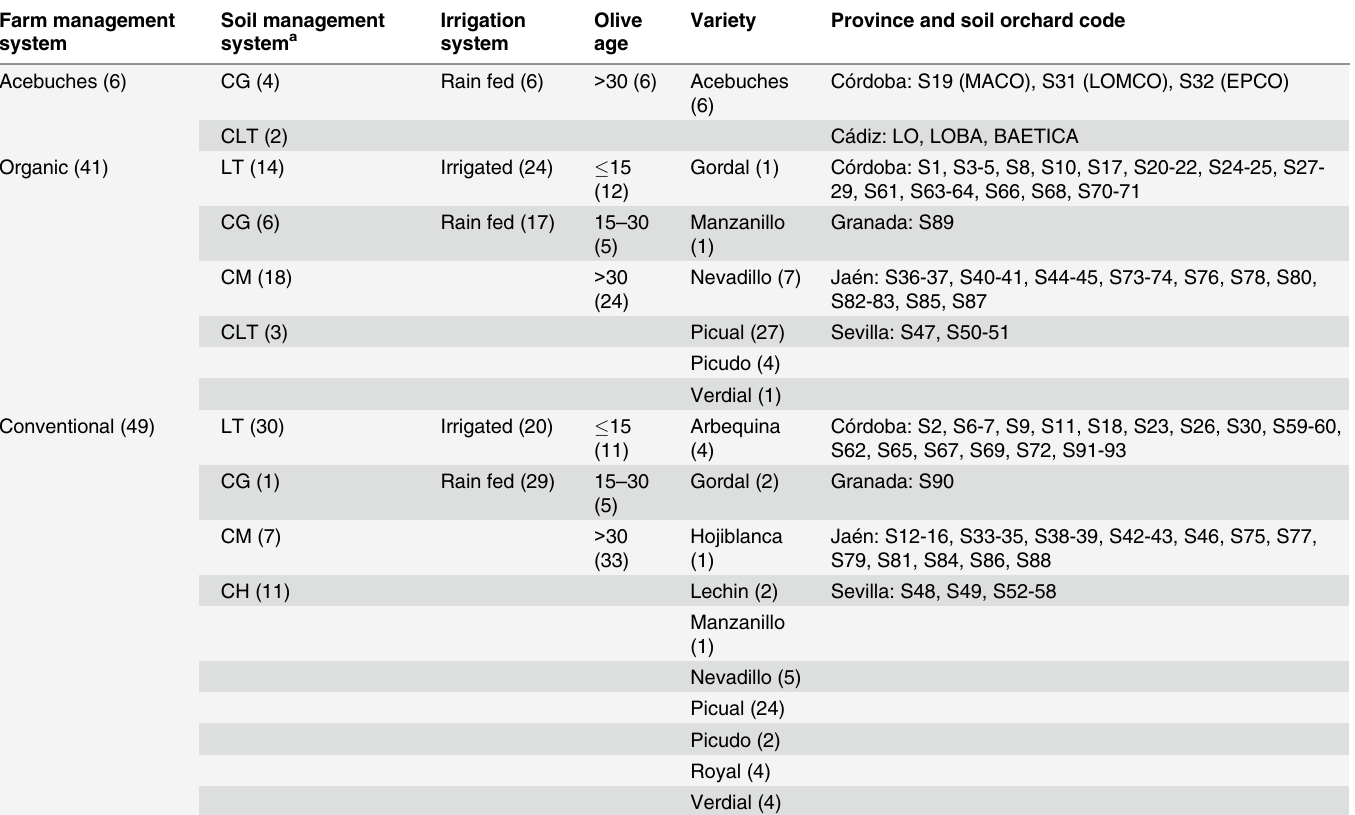
Table 1. Characteristics and code of olive orchard soils evaluated in this